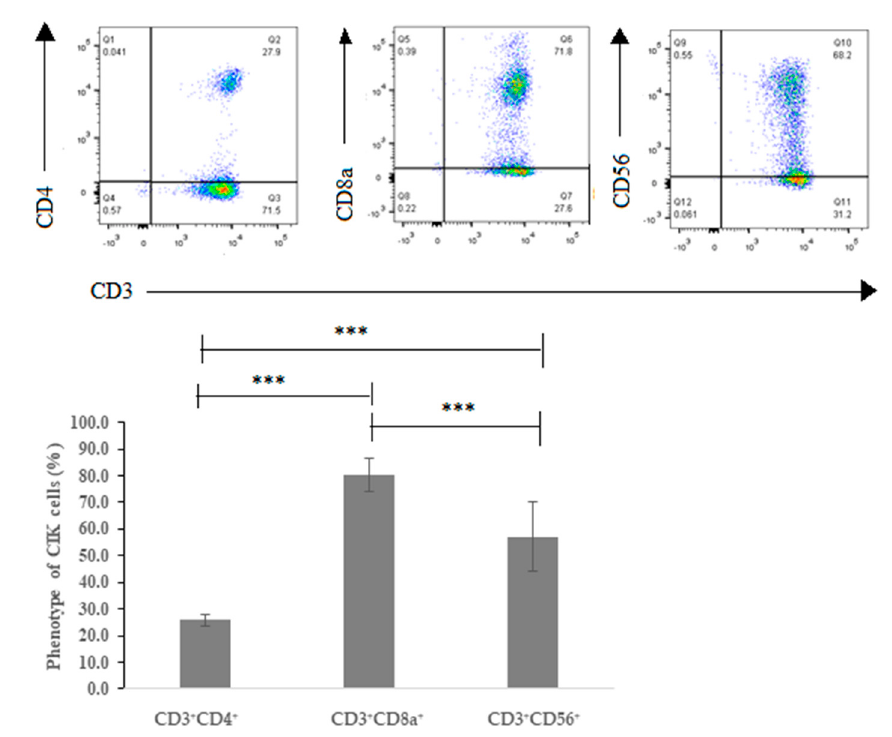
Figure 1. Main phenotype of cytokine-induced killer (CIK) cells derived from donors ( n = 3) on day 14. Differential expression of three main phenotypic subsets of CIK cells, CD3/CD4/CD8. *** represents a p value < 0.001.